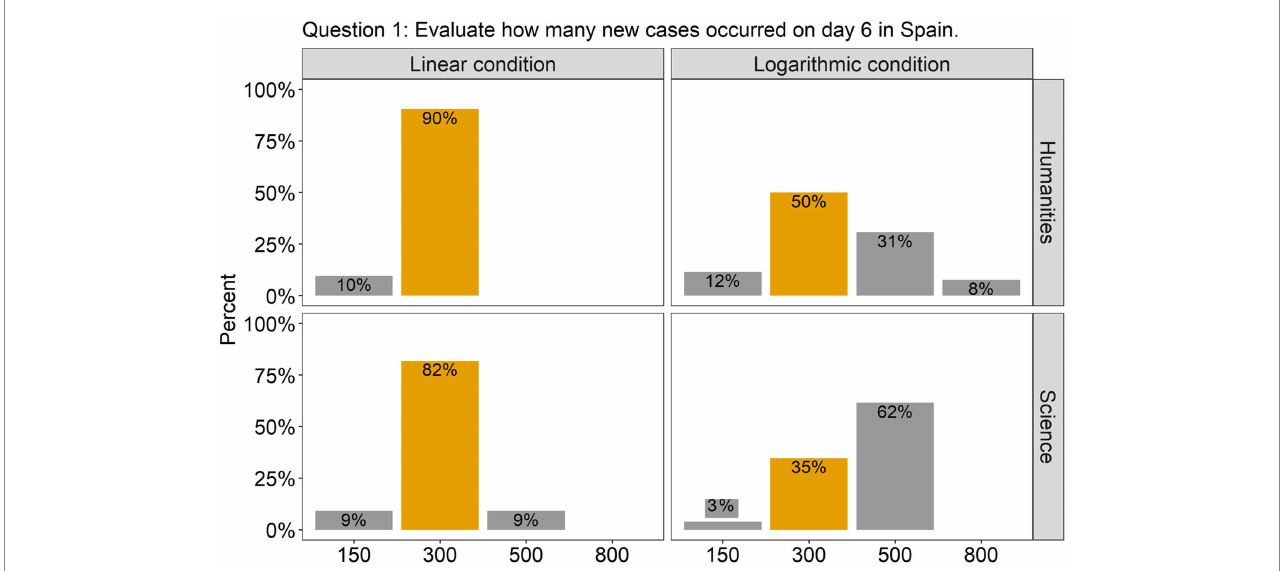
FIGURE 2 The barplots present the distribution of the participants’ answers to Question 1 (graph description question). The correct answer is indicated with orange- colored bars.